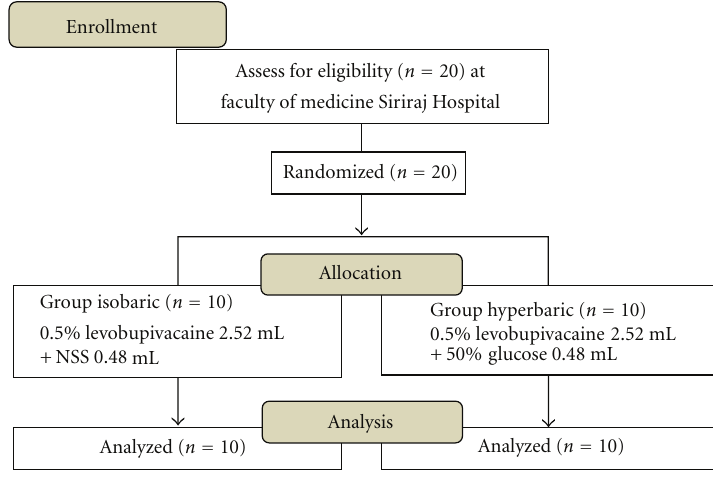
Figure 1: CONSORT flow diagram.